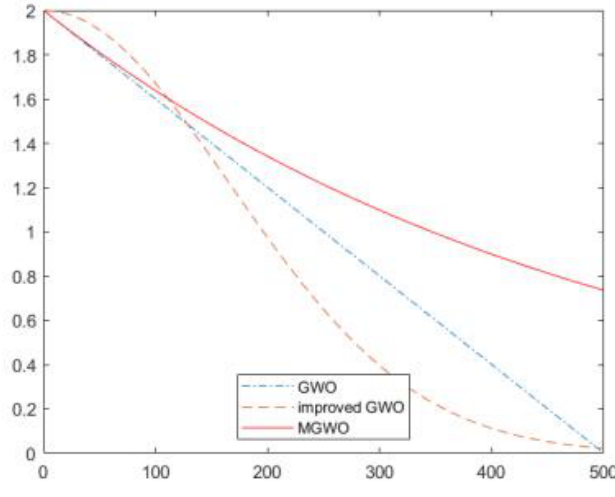
Figure 4. Convergence